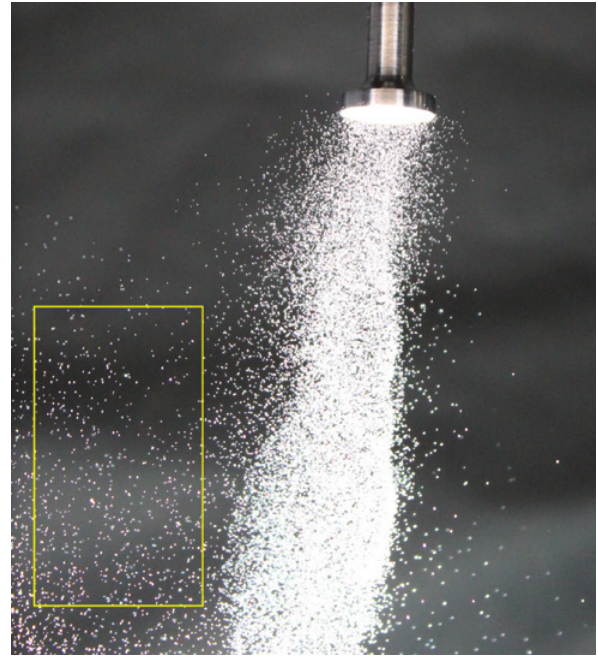
Figure 2: Droplets used for analysis using Image J software.